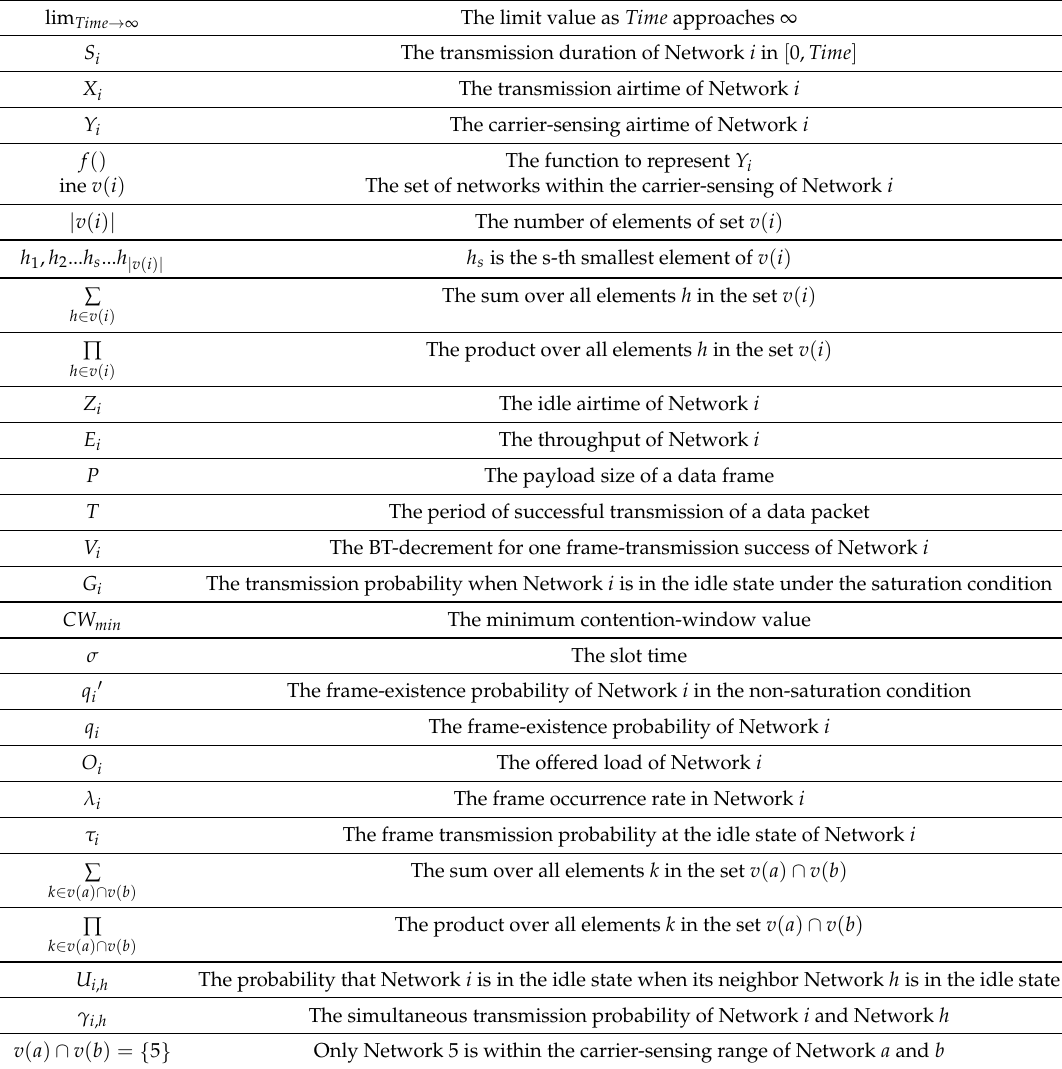
Table 1. Mathematical